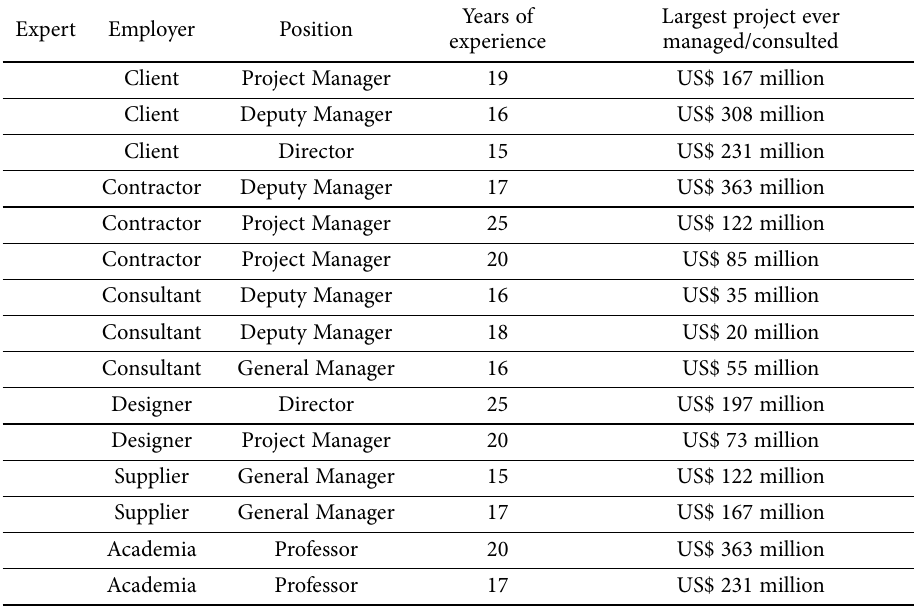
Table 1. Profile of the Delphi panel